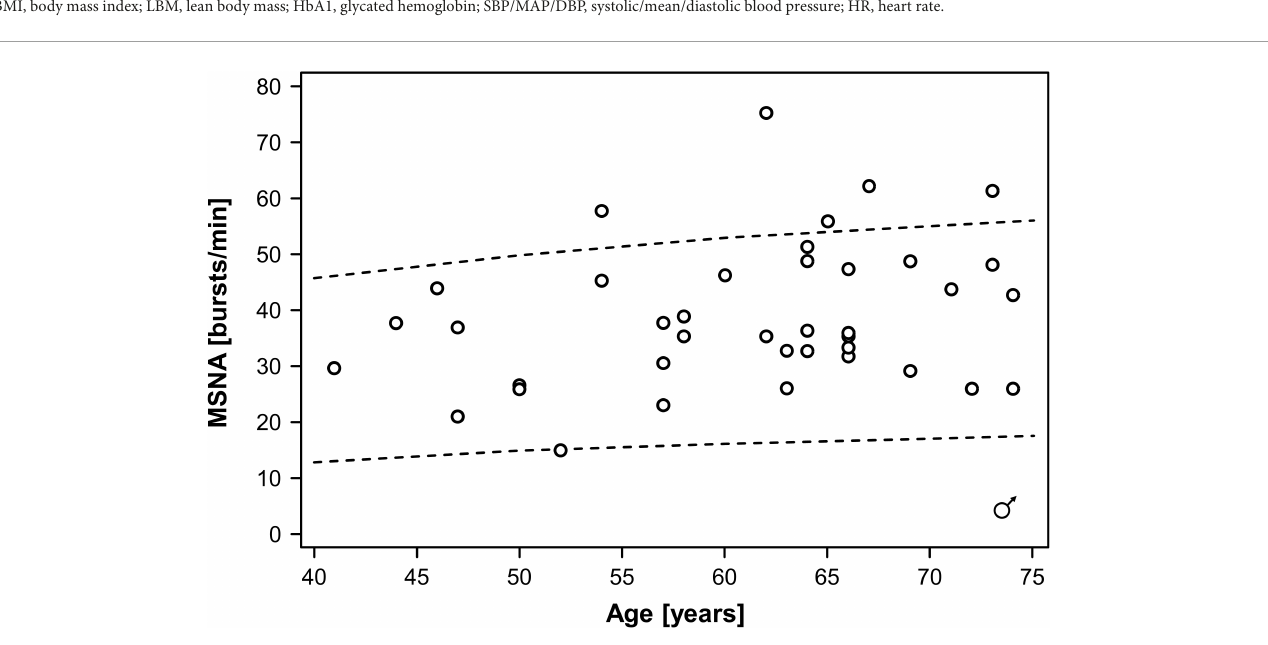
FIGURE1 Muscle sympathetic nerve activity (MSNA) over age in men with type 2 diabetes mellitus. Dots indicate individual patients. The dashed lines indicate the 5th and the 95th percentile of MSNA in different age groups from a previous study in healthy persons (Keir et al.,